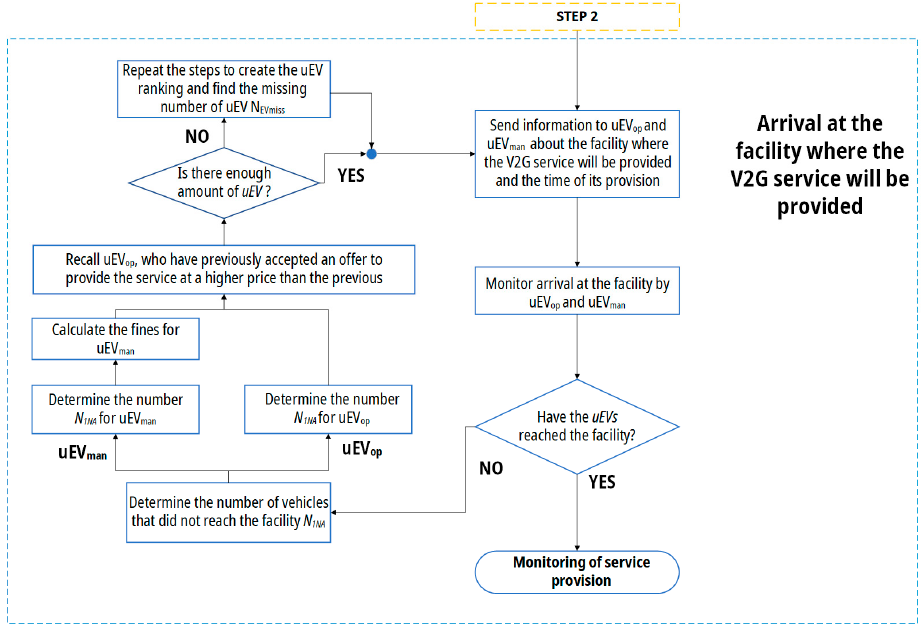
Figure 7. Third part of proposed algorithm—arrival at the facility where the V2G service will be